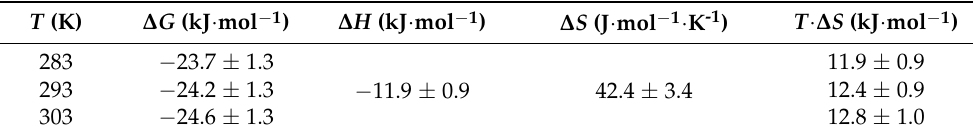
Table 2. Thermodynamic parameters of the complex NBD-PPL at the temperatures of 283, 293 and 303